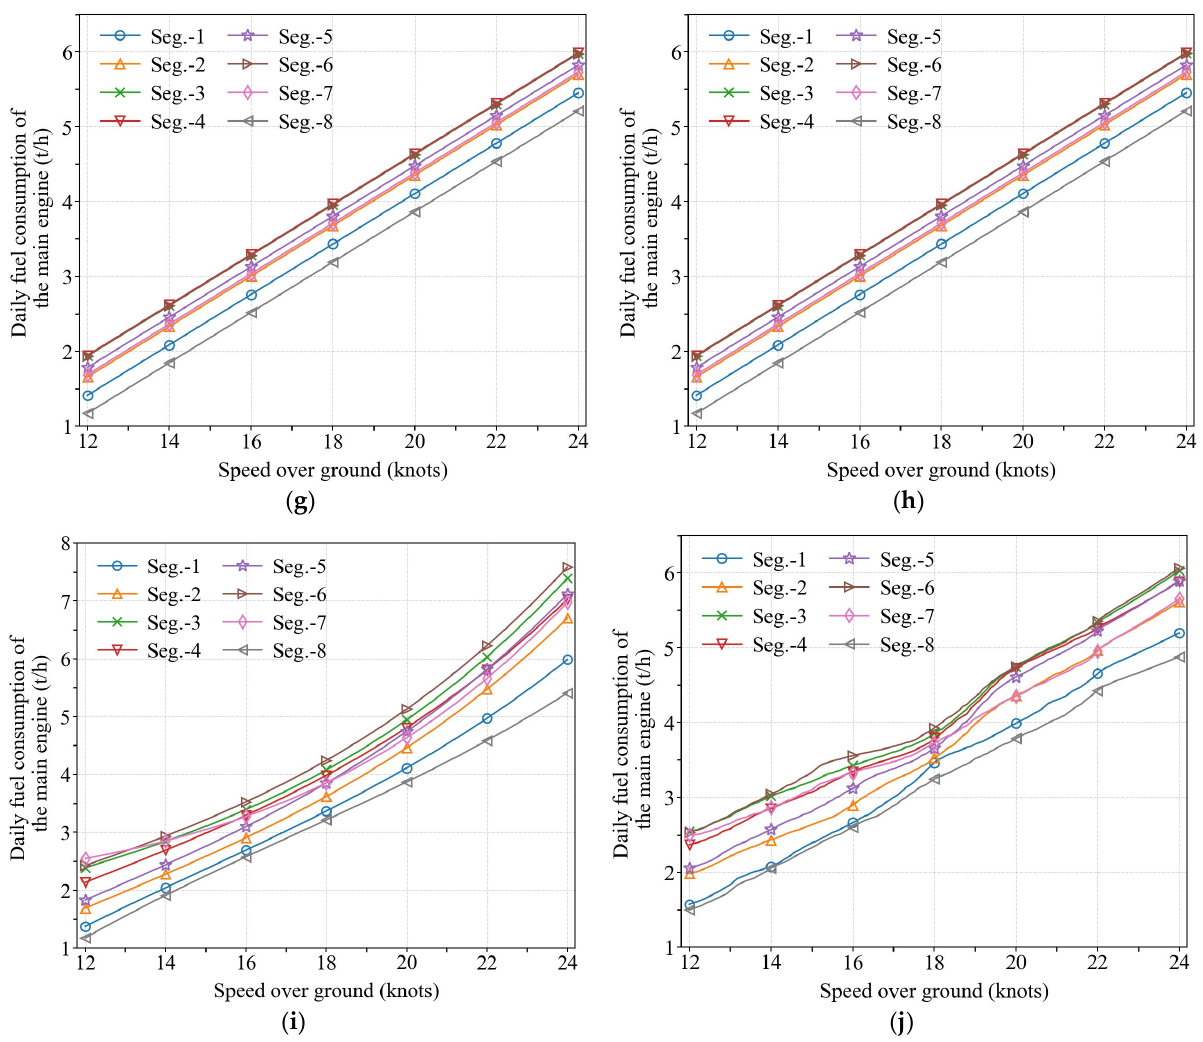
Figure A1. The variation trend of main engine fuel consumption predicted by each model with ship speed. ( a ) RF. ( b ) ET. ( c ) AB. ( d ) GB. ( e ) SVR. ( f ) ANN. ( g ) Ridge. ( h ) LASSO. ( i ) PR. ( j ) VR. The model comparison results show that the ET model has the highest prediction accuracy, the PR model has the highest prediction reliability, and the rest of the models have different degrees of disadvantages in both aspects. Therefore, we finally choose to integrate the ET model with the PR model to construct the VR model for fuel consumption prediction, and the results of the VR model also confirm the advantages of model integration.